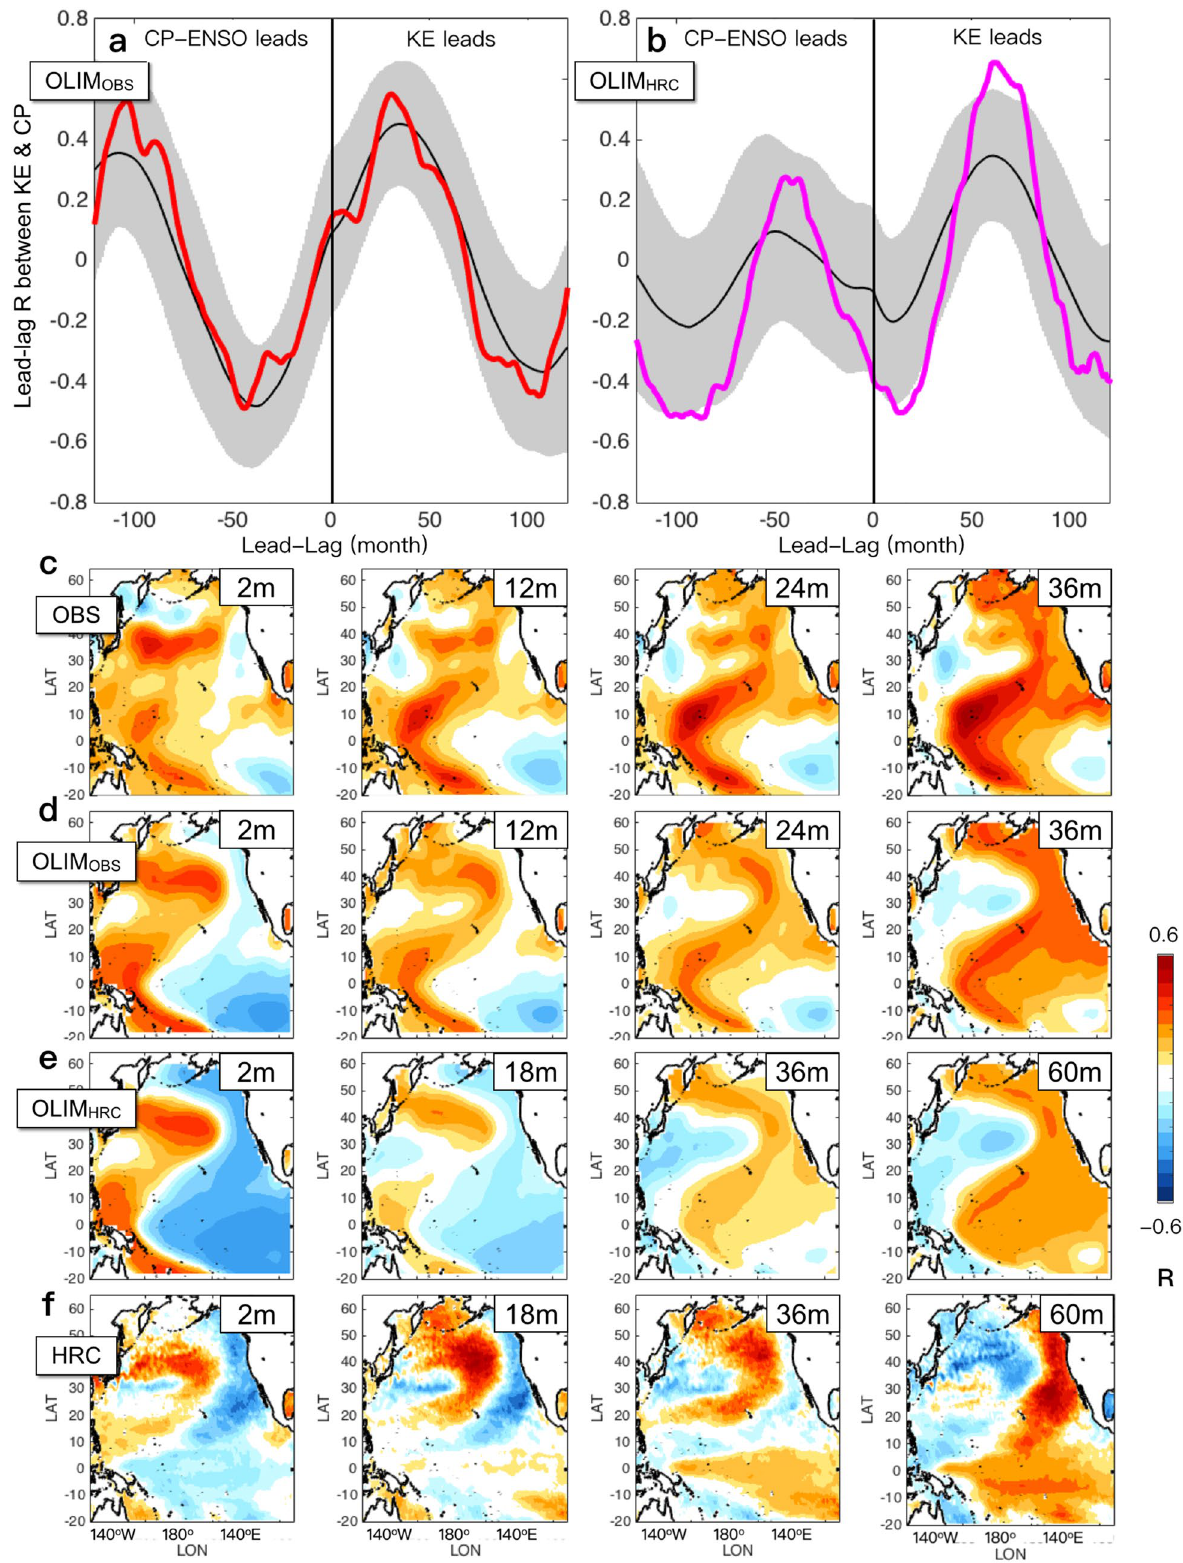
Figure 4. Variation of the extratropical-tropical KE system in the presence of stochastic noise forcing. 50-member subsets of OLIM(P2) that best fit to the ( a ) observed (OLIM OBS ) and ( b ) simulated (OLIM HRC ) lead-lag correlation between the KE and CP-ENSO indices, where ensemble means and references are denoted as black and red/pink lines with the two standard-deviation confidence interval (shading) in OLIM OBS and OLIM HRC respectively. The dot indicates the grid whose signal is above 95% significance level based on the student t-test. SST progression of KE in the ( c ) observations, ( d ) OLIM OBS , ( e ) OLIM HRC , and ( f ) OLIM HRC . The figures are provided using MATLAB R2017a (https:// www. mathw orks. com/ produ cts/ new_ produ cts/ relea se201 7a.